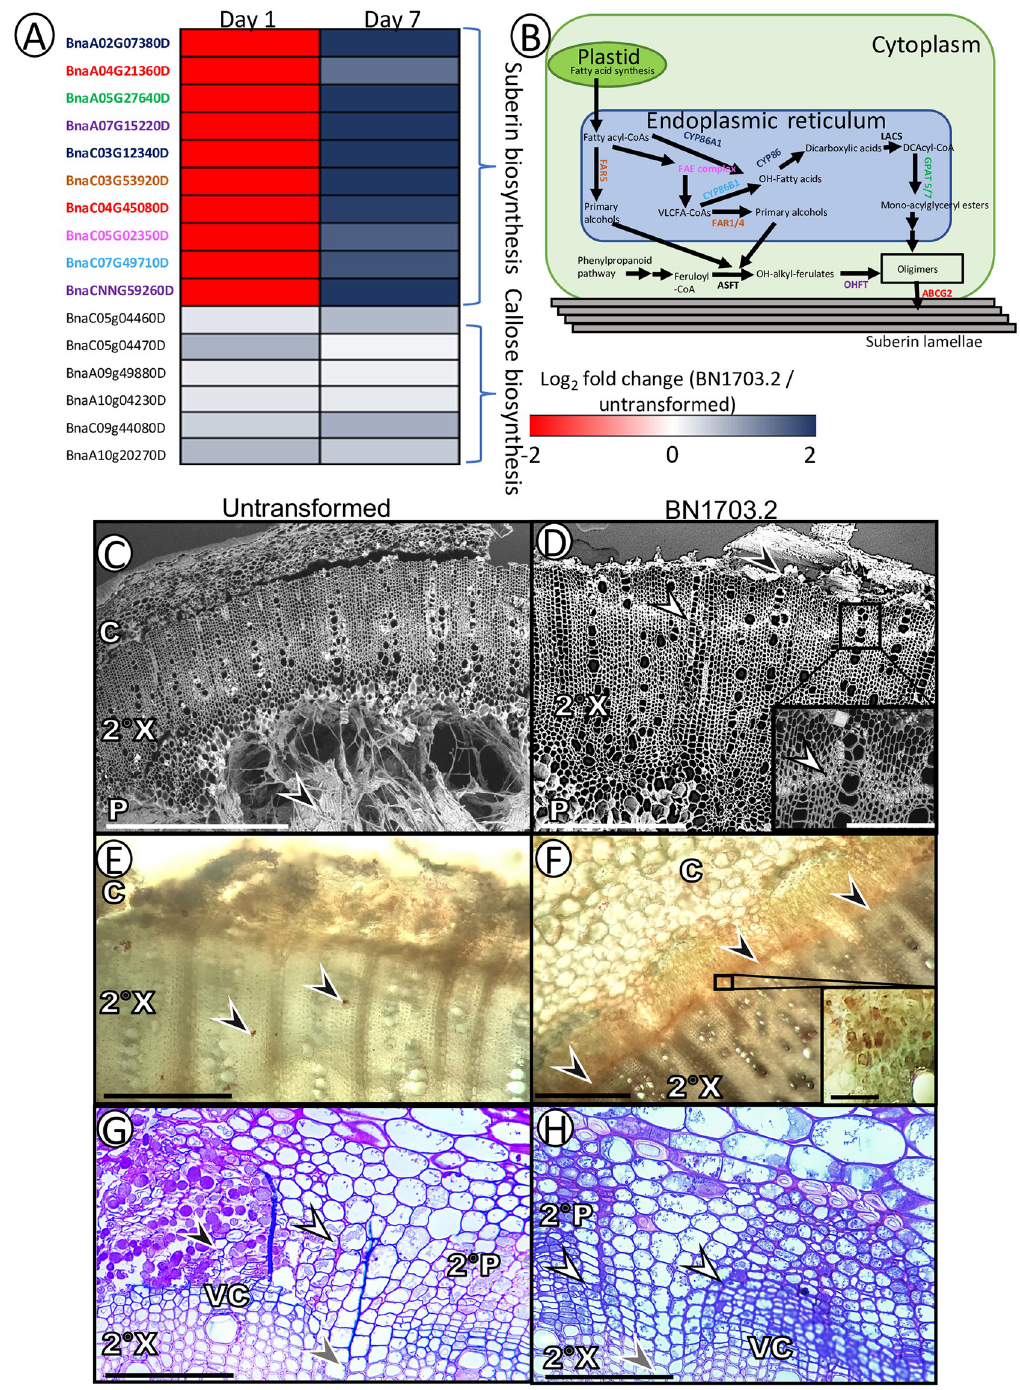
Fig 5. Structural differences between BN1703.2 and untransformed lead to enhanced protection from S . sclerotiorum . (A) Heatmap of genes involved in suberin and callose biosynthesis, which were enriched GO terms for BN1703.2. GO terms are considered statistically significant if the hypergeometric P-value < 0.001. (B) A diagram of the biosynthesis pathway of suberin in plant cells. The enzyme font color corresponds to the B . napus gene ID in the heatmap in (A). Scanning electron micrographs of infected B . napus stems 7 days post-inoculation in untransformed (C) and BN1703.2 (D) genotypes. The untransformed stem shows extensive colonization throughout, particularly the pith (P) region. The BN1703.2 stem shows no colonization of the pith and a vascular coating within the secondary xylem (2˚X). Scale bars represent 1 mm for untransformed and 0.5 mm and 50 μ m for BN1703.2. Black arrowheads indicate Sclerotinia hyphae and white arrowheads indicate the vascular